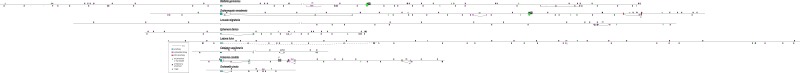
Diverse basal Hexapods include a motif (15) found in both the termite and cockroach.